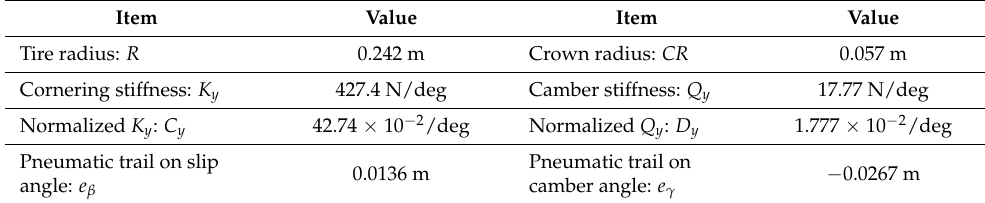
Figure 3. Motorcycle tire model is used in CarMaker [13]. Table 2. Parameters of Tire (100/90R12), Vertical load: F z =